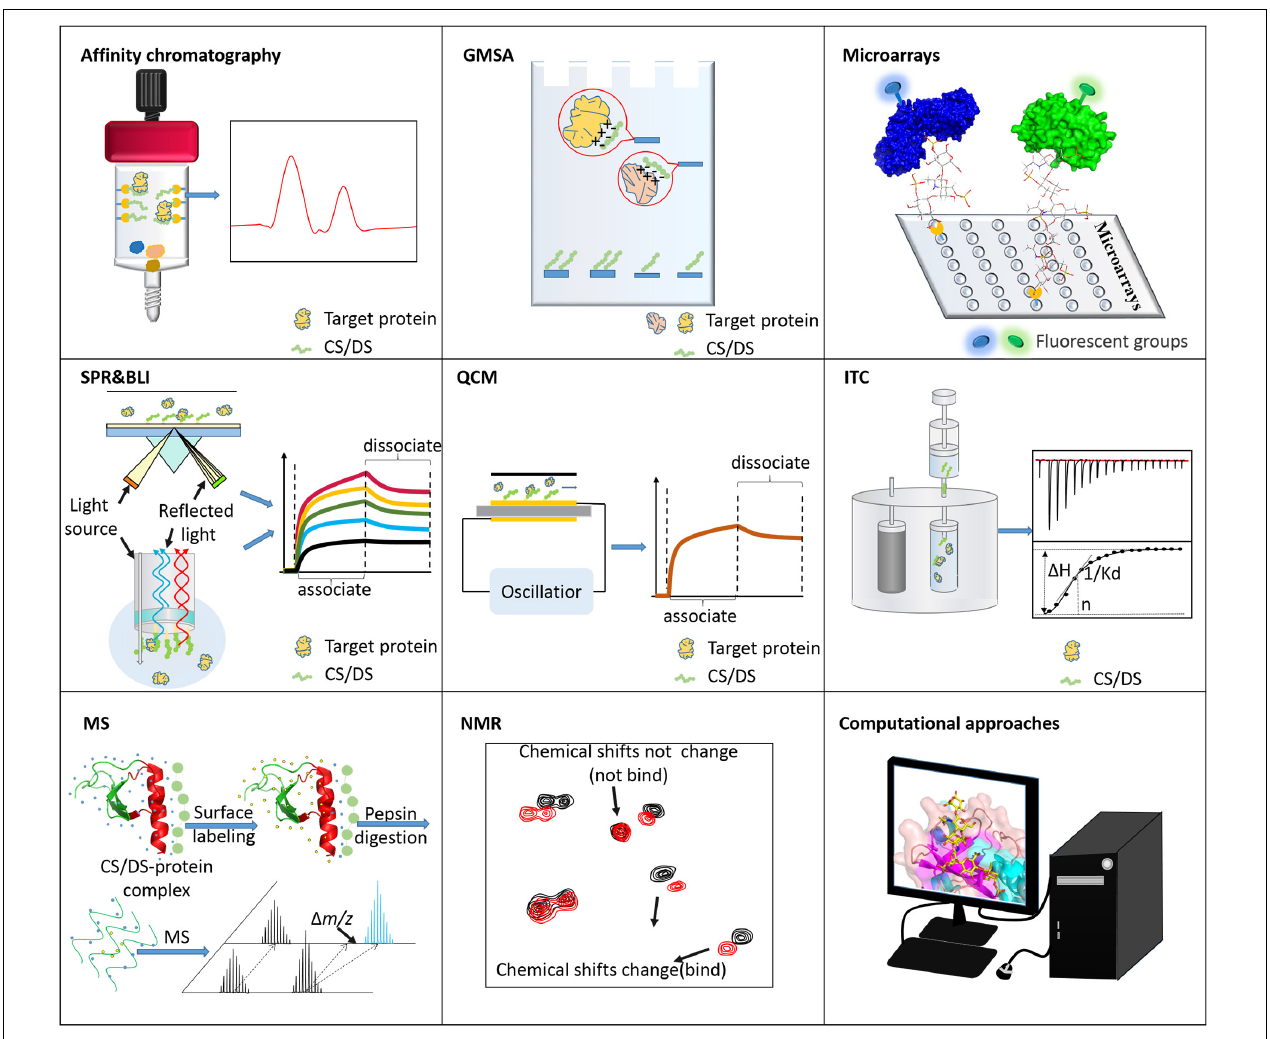
FIGURE 4 | Tools for analyzing CS/DS-protein interactions. Affinity chromatography is usually used to isolate binding molecules or fragments. GMSA and microarrays are used to screen the CS/DS or proteins that bind to each other. ITC, SPR, BLI, and QCM can measure the binding strength between CS/DS and proteins. MS and NMR are applied to characterize the structure/sequence of binding motifs. Computational approaches are powerful for simulating the binding postures of these two types of